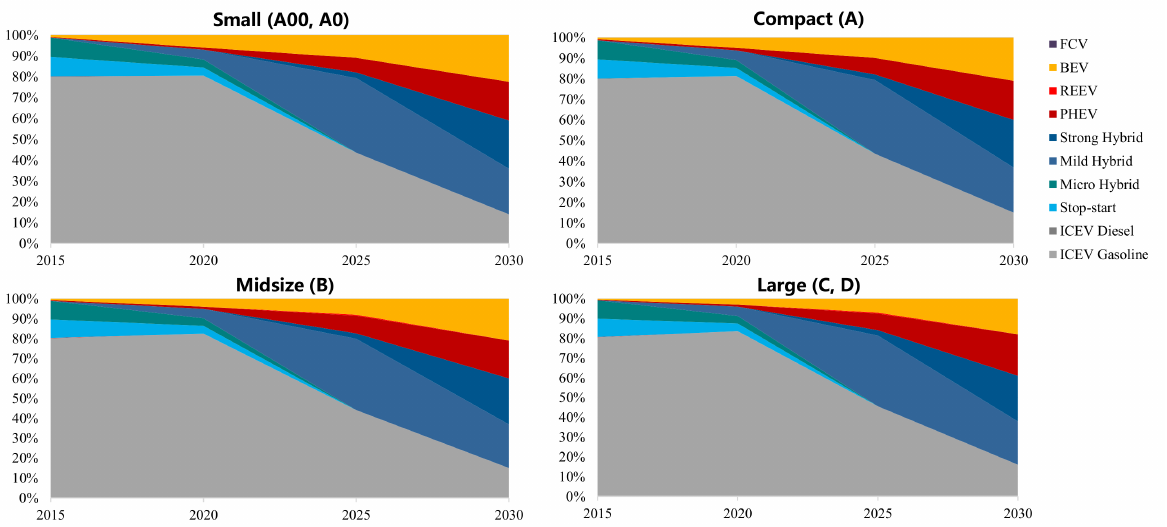
Figure 10. Penetration of different powertrains in the Chinese